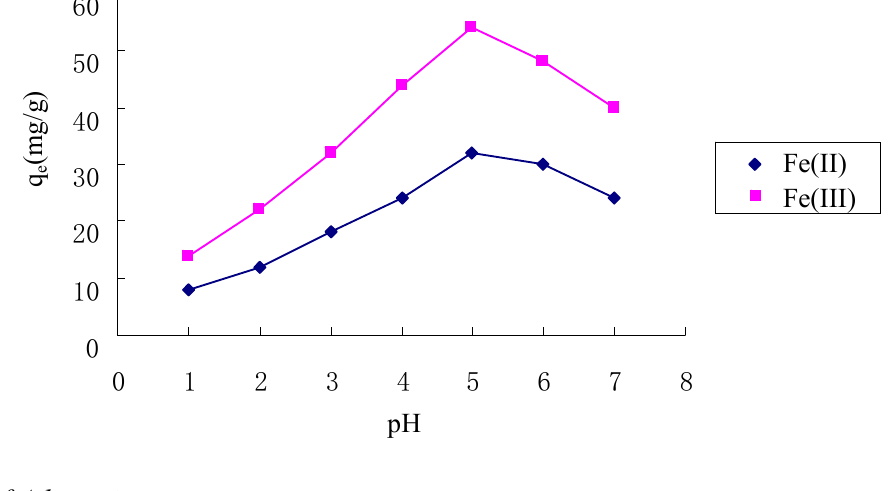
Figure 3. Effect of pH on adsorption of Fe(II) and